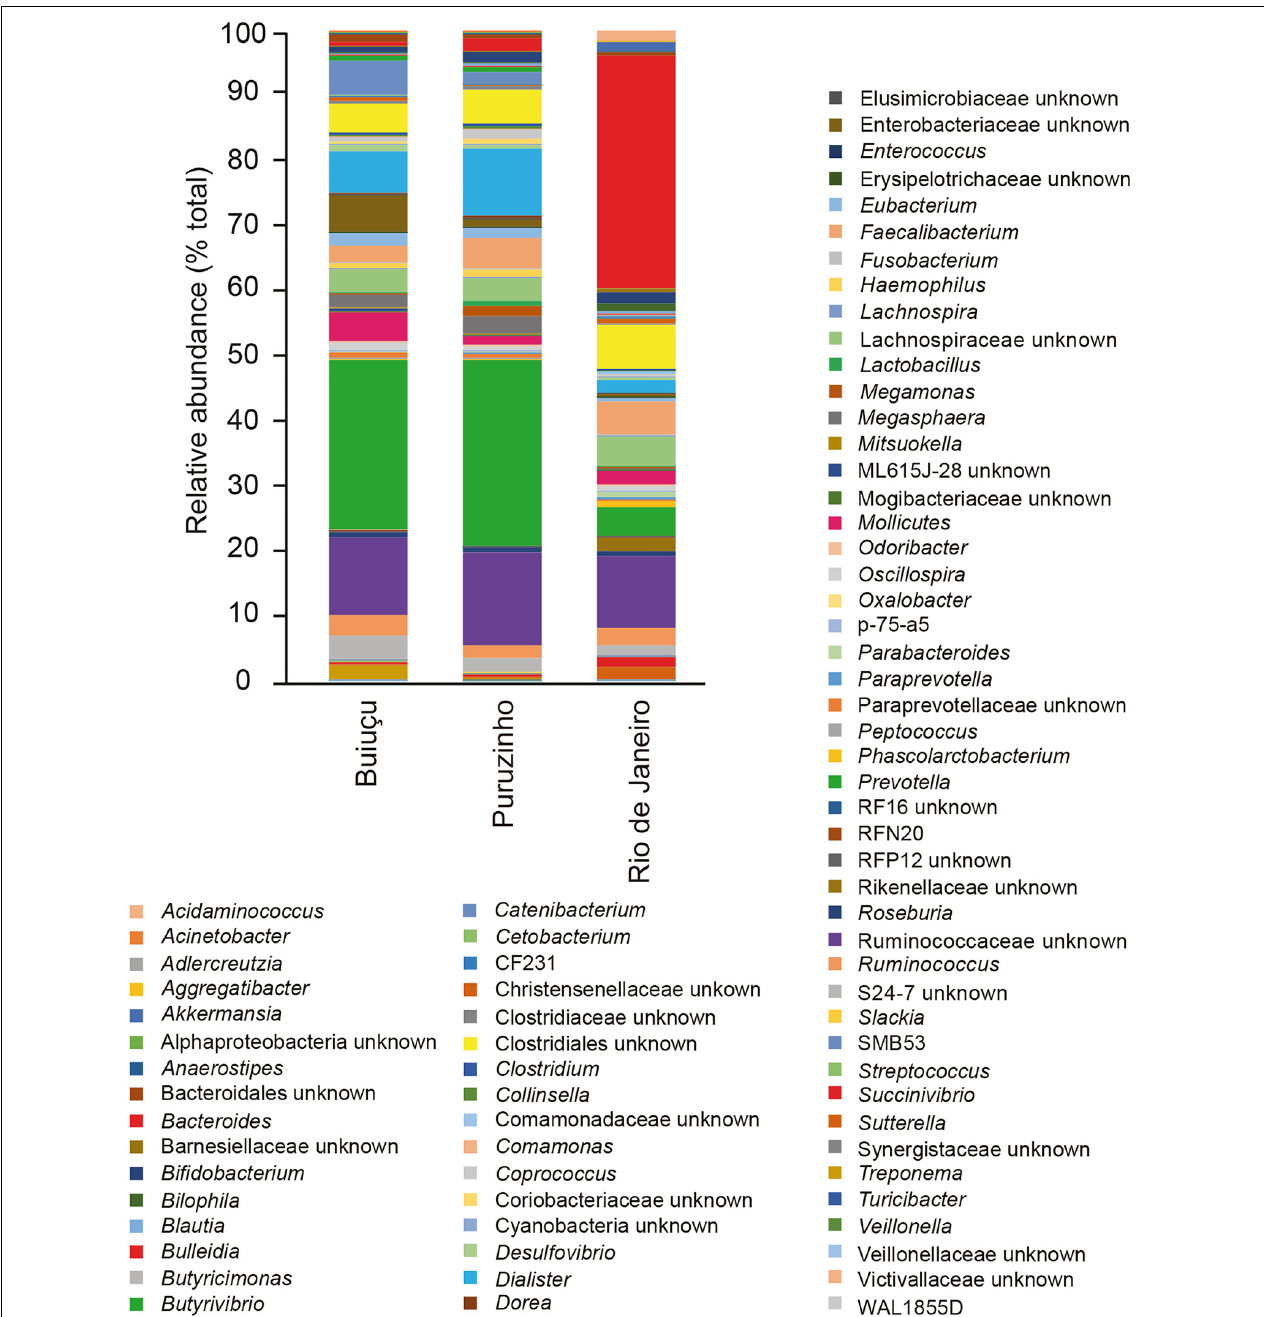
FIGURE 2 | Relative abundance of bacterial genera in the gut microbiome of individuals from the three communities